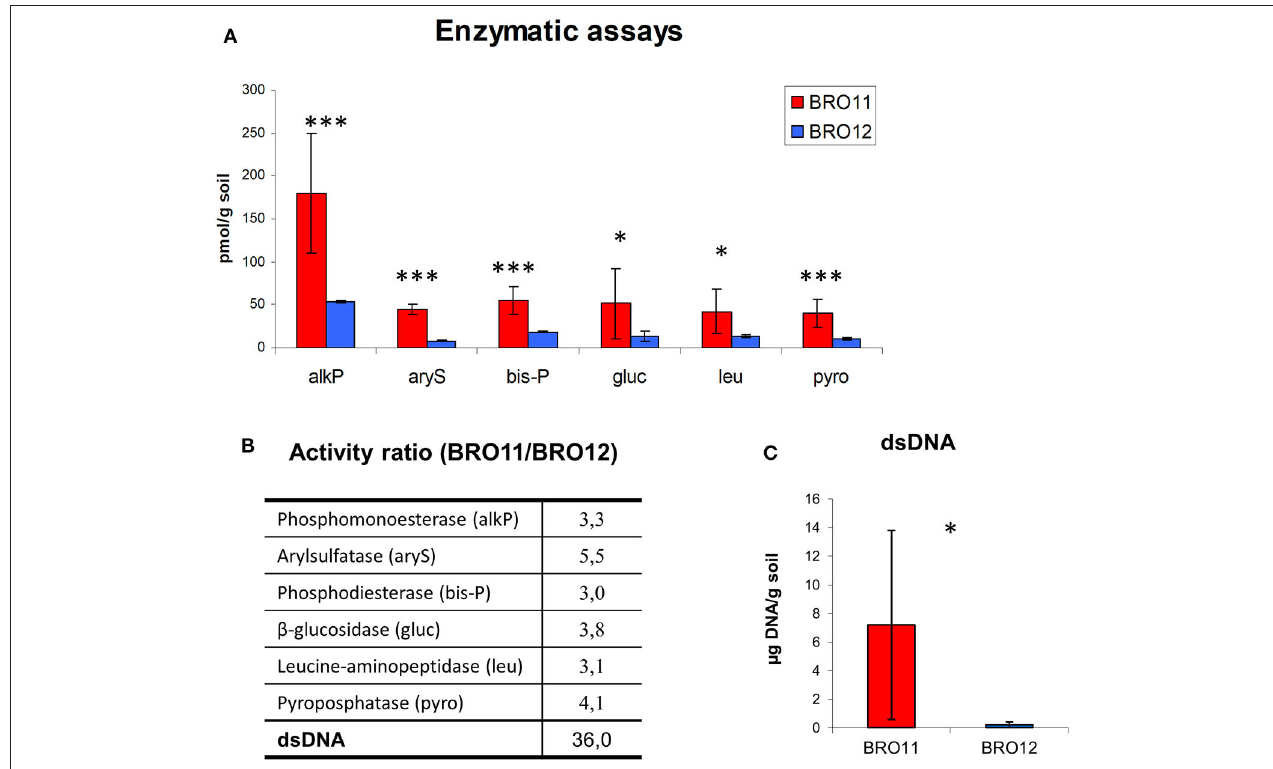
FIGURE 6 | (A) Enzymatic activities detected in BRO11 and BRO12 soils and the amount of dsDNA extracted with the same procedure used for enzymes. Asterisk indicates significant differences of the variable means between BRO11 and BRO12 genes ( p < 0.05); (B) the activity ratio among BRO11/BRO12 values indicate the relative enzymatic activity and dsDNA amount in the two soils. (C) Total amount of the dsDNA extracted from BRO11 and BRO12 soils. Asterisks indicate significant differences of the variable means between BRO11 and BRO12 sites (* p < 0.05; and *** p <